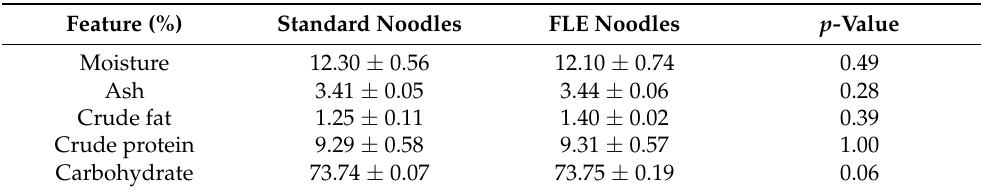
Table 1. Contents of carbohydrate, crude protein, fat, moisture, and ash in standard (without fermented lettuce extract (FLE)) and noodles with